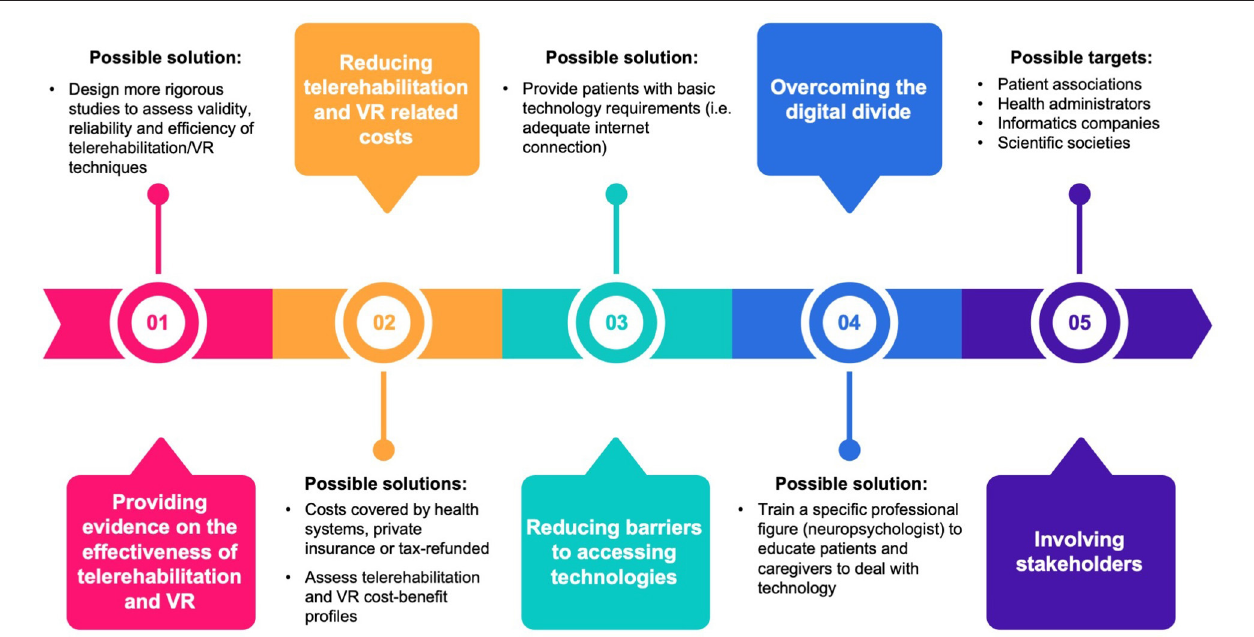
FIGURE 1 | Issues related to cognitive telerehabilitation and possible solutions. VR, virtual reality.